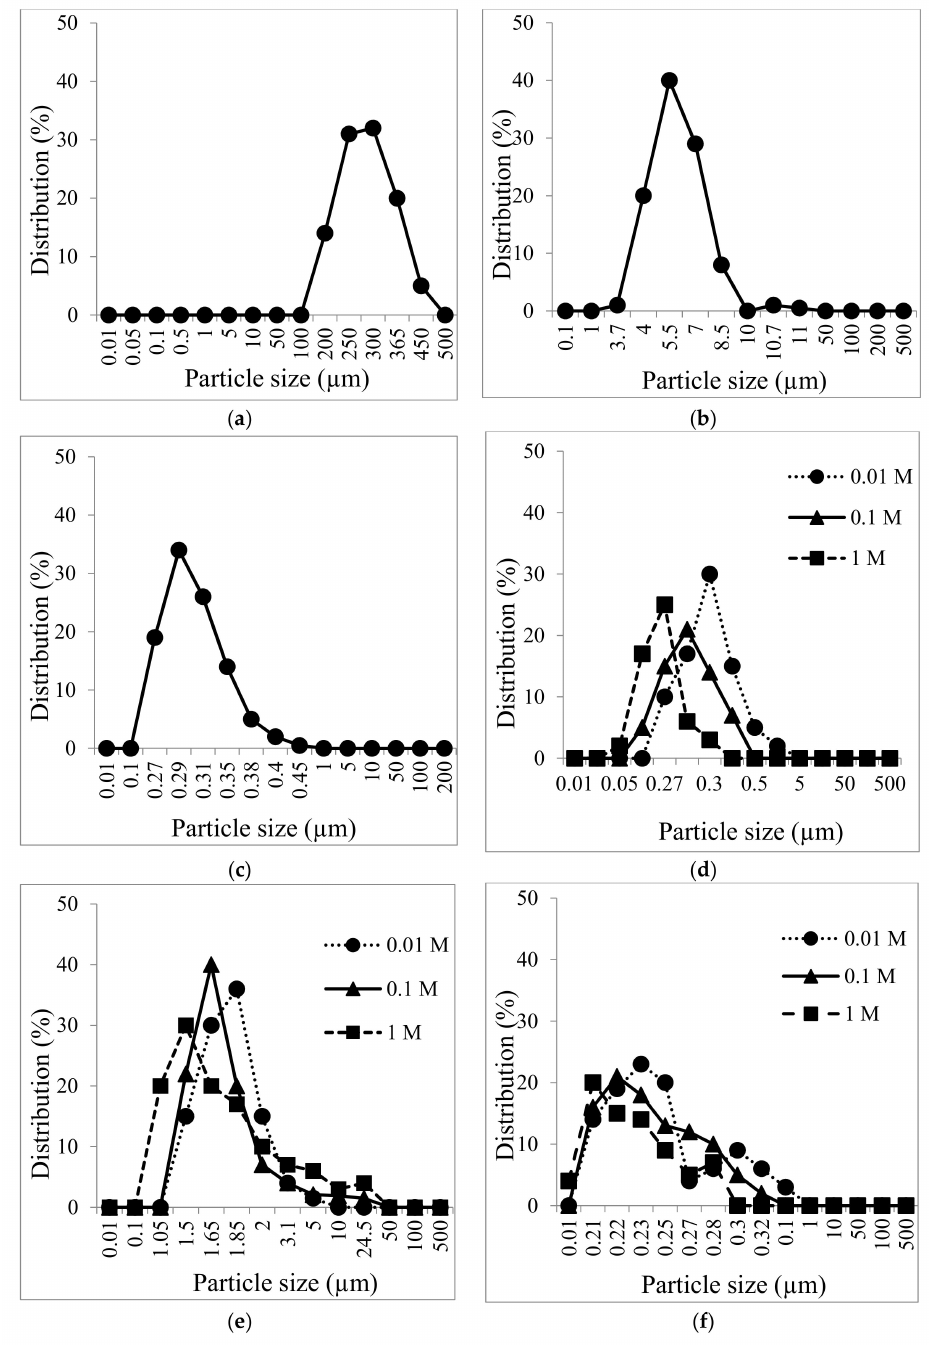
Figure 6. Particle size distribution analyses of soil sample exposed with no additive at ( a ) 0 W ( b ) 600 W and ( c ) 1200 W and with (0.01–1 M) additive under 1200 W with ( d ) NH 3 ( e ) HCl( f )